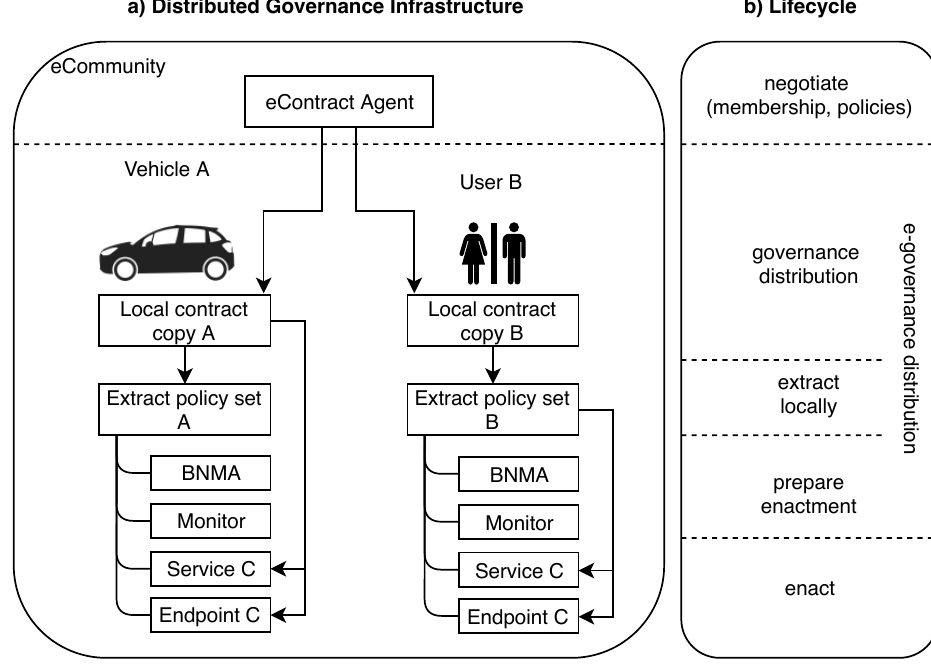
Figure 3. Distributed M2X governance infrastructure. Source: [1] and based on